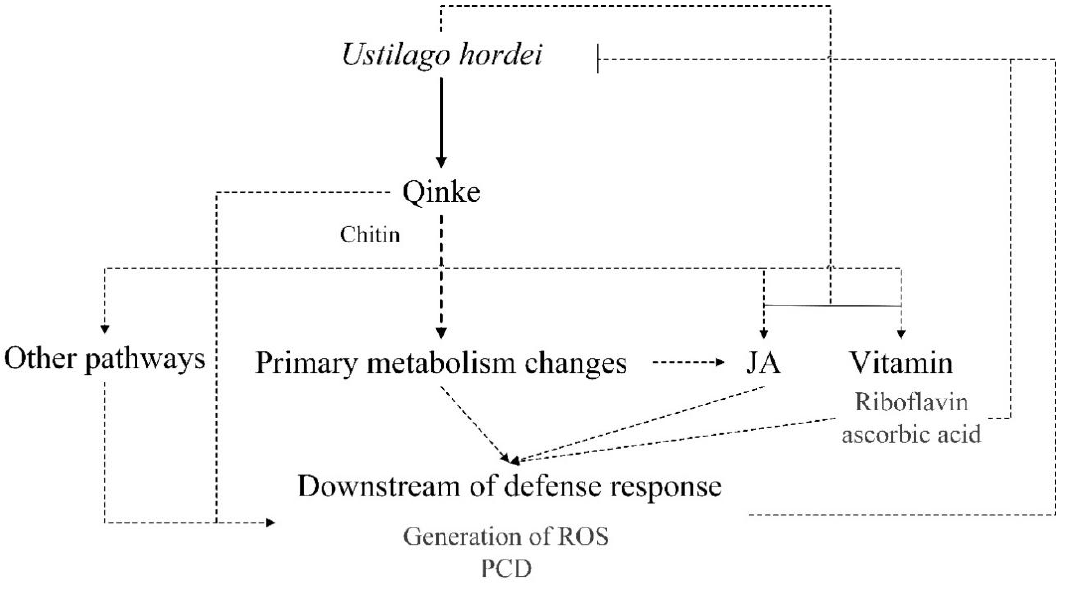
Figure 4. Hypothesis model of qingke interacted with Ustilago hordei. Arrow indicated activation and horizontal line indicated repression, dotted line indicated need to further biological evidence in qingke.